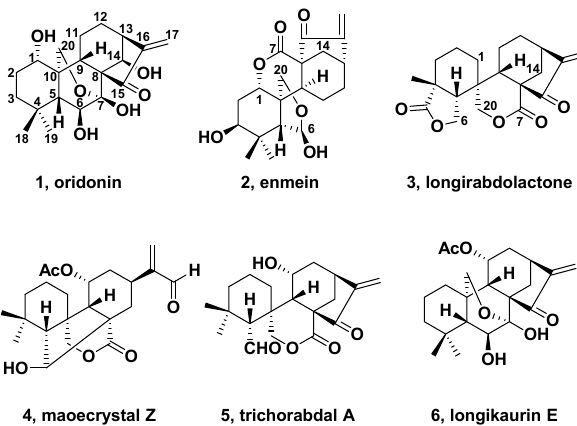
Figure 1. Structures of oridonin ( 1 ), enmein ( 2 ), longirabdolactone ( 3 ), maoecrystal Z ( 4 ), trichorabdal A ( 5 ), and longikaurin E ( 6 ).